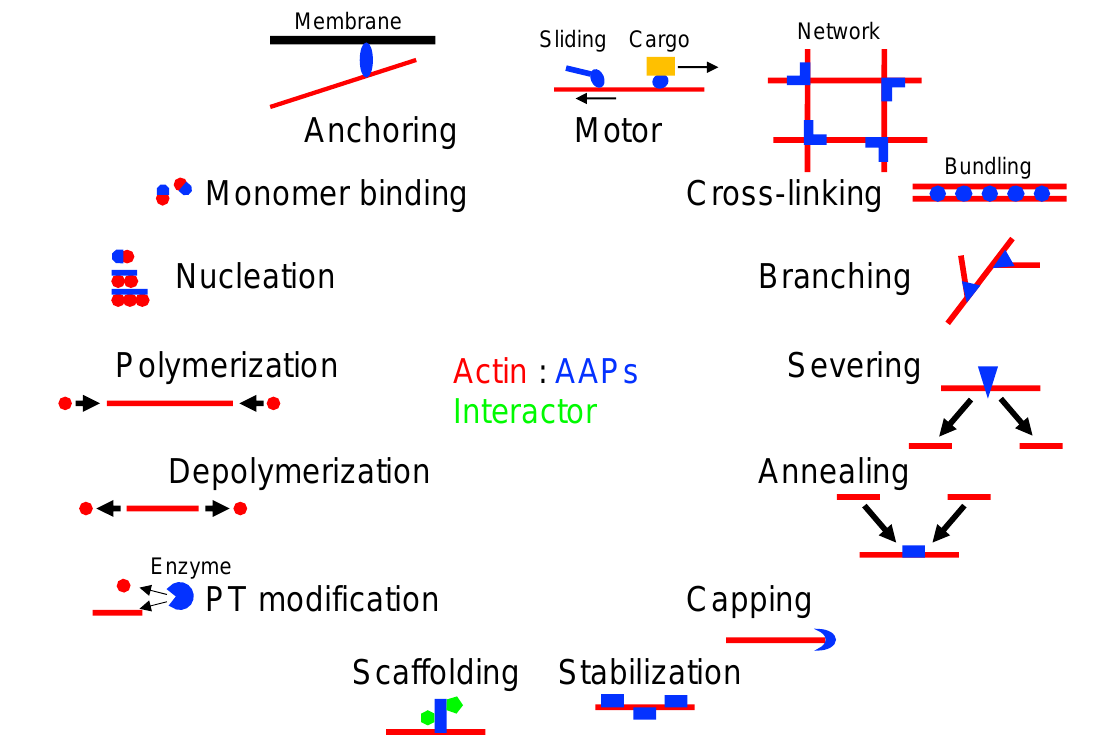
Figure 2. How AAPs interact with actin, regulate the assembly and disassembly of actin, connect, and move; post-translational (PT) modification. See also Table S1.